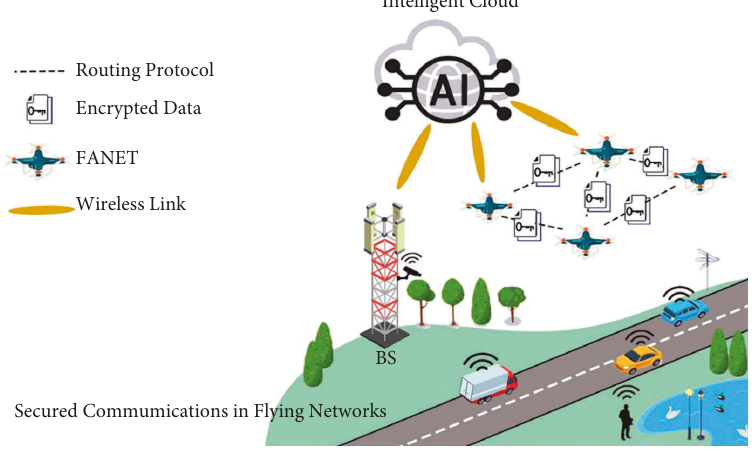
Figure 1: AI-enabled secure communication in flying